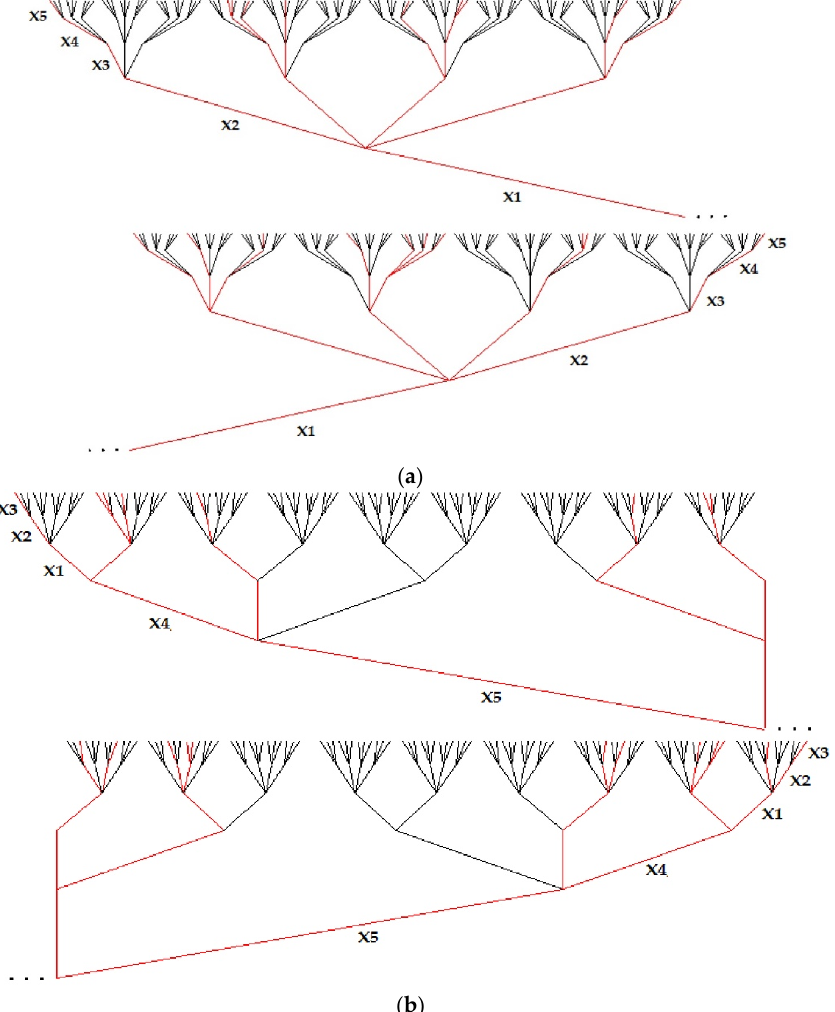
Figure 4. Exemplary multi ‐ valued logic trees for floor layouts: ( a ) X 1 , X 2 , X 3 , X 4 , X 5 , and ( b ) X 5 , X 4 , X 1 , X 2 , X 3 .